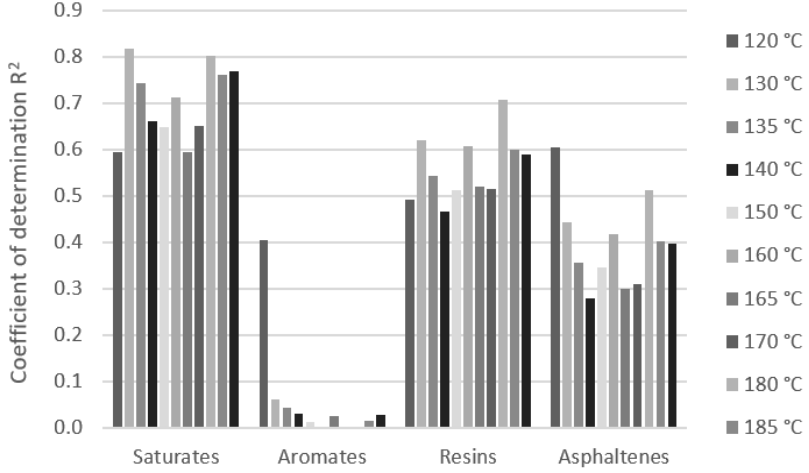
Figure 10. Coefficient of determination of linear model of dynamic viscosity and SARA composition at temperatures in the range 120 to 190 °C for group modified bitumen 45/80-75 samples.